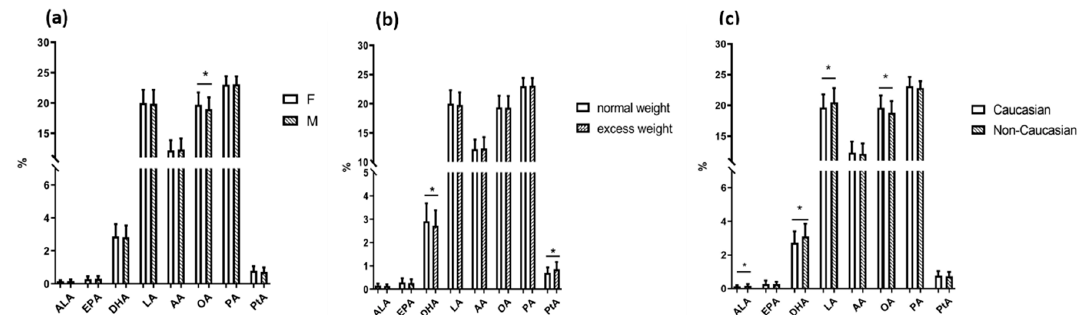
Figure 1. Fatty acid profile of children grouped according to gender ( a ), adiposity ( b ), and ethnicity ( c ). Legend: ALA: alpha-linolenic acid; EPA: eicosapentaenoic acid; DHA: docosahexaenoic acid; LA: linoleic acid;AA: arachidonic acid; OA: oleic acid; PA: palmitic acid; Pta: palmitoleic acid. 2.2. Correlations of Fatty Acids and Desaturase Activities with Anthropometric and Clinical Parameters in the Whole Sample